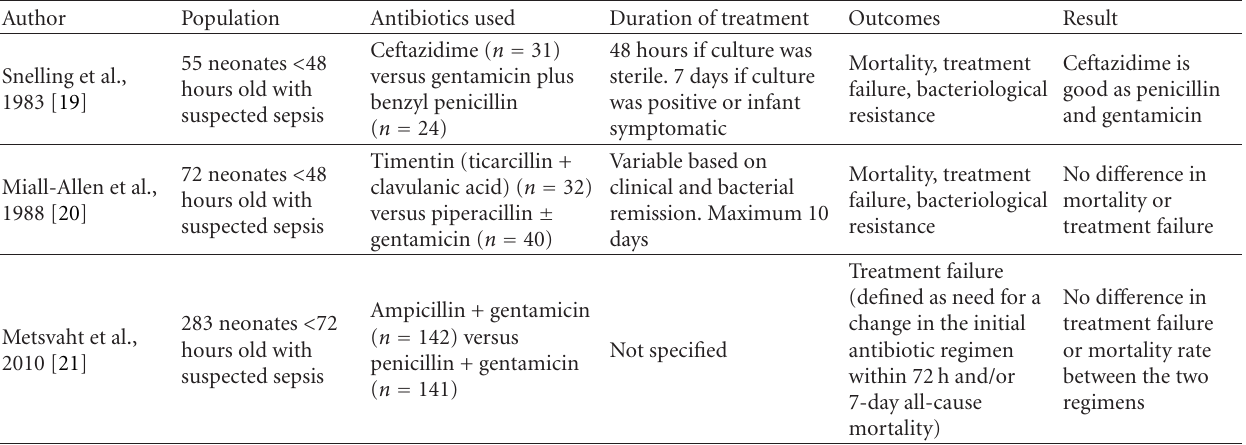
Table 1: Randomized controlled trials on empirical antimicrobial therapy for suspected early-onset